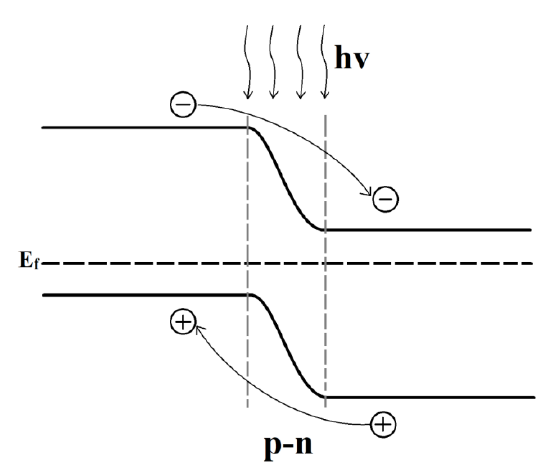
Figure 8. The operation process of photosensitive structure (schematically).